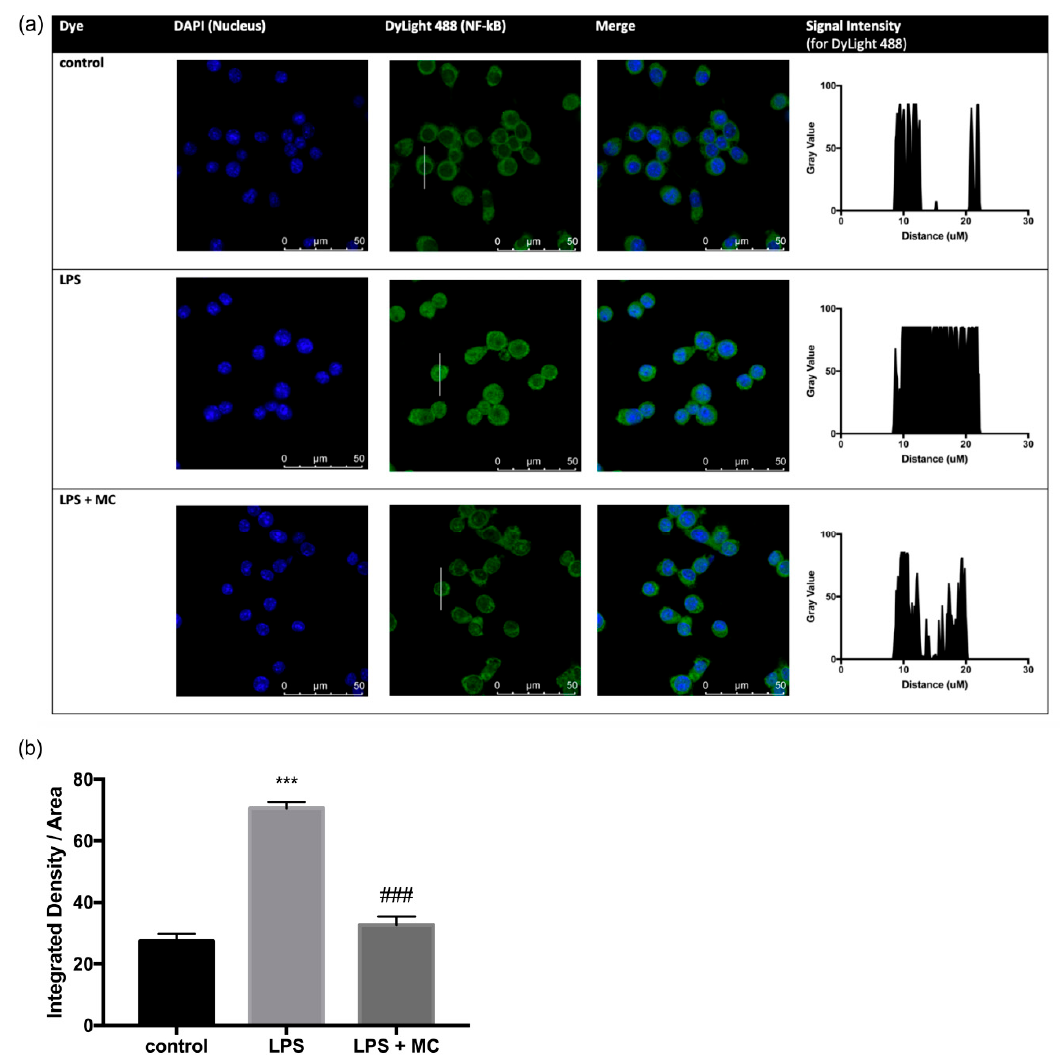
Figure 2. MC pre-treatment inhibited LPS-induced NF- κ B translocation in RAW264.7 cells. ( a ) Immunofluorescence staining images for macrophages treated with or without LPS and MC. Right panel shows the gray value plot profile, which is representative of fluorescence intensities along the length of a drawn line shown in the middle panel, ( b ) Integrated density per area of cell, which represents the average intensity of protein immunostaining. In Figure 2a, the green dye 488 of control group showed a disk-like shape with a hollow center, suggesting that NF- κ B was mainly present in cytoplasm. With LPS treatment, the 488 dye appeared brighter and the center of the cell was stained and in the merged image, the green dye and 4 (cid:48) ,6-diamidino-2-phenylindole (DAPI) overlapped each other, implying the presence of NF- κ B in the nucleus of the cell. In the treatment group, a hollow disk-like shape was observed with the stain of 488 dye, and the merged image showed that the DAPI-stained nucleus was surrounded with a ring of green dye, showing that NF- κ B was mainly present in the cytoplasm. *** p < 0.001 compared with the control group. ### p < 0.001 compared with the LPS